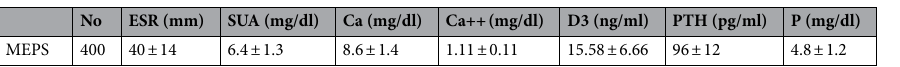
Table 2. Laboratory chemistry and PTH results of MEPS study group. ESR erythrocyte sedimentation rate, SUA serum uric acid, Ca total calcium, Ca ++ ionized calcium, D3 vitamin D3, PTH parathyroid hormone, P serum